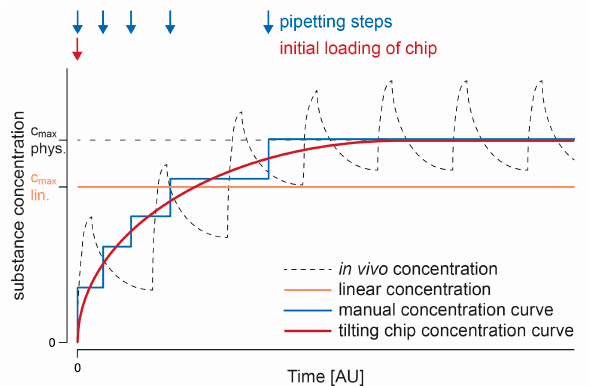
Figure 1. Schematic illustration of different in vivo and in vitro dosing curves. While linear exposure profiles (orange) may lead to false results during efficacy or toxicity testing, manual modulation of the concentration (blue) entails multiple, laborious pipetting steps. The tilting platform enables physiologically relevant, gradual changes of substance concentrations (red) without additional experimental steps.